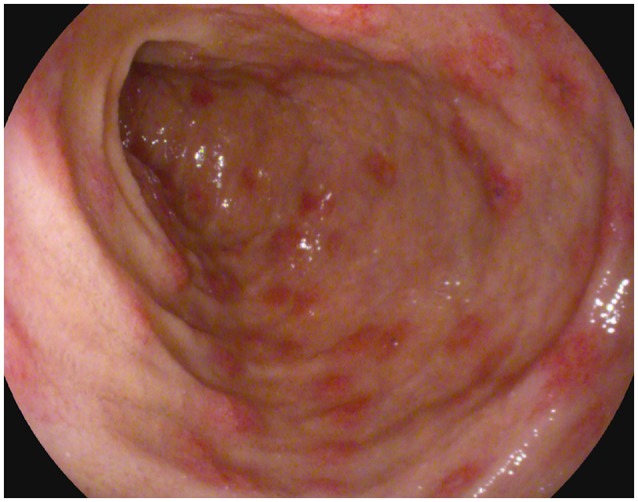
Esophagogastroduodenoscopy evidence of multiple hyperemic and hemorrhagic round-shaped lesions in distal duodenum.